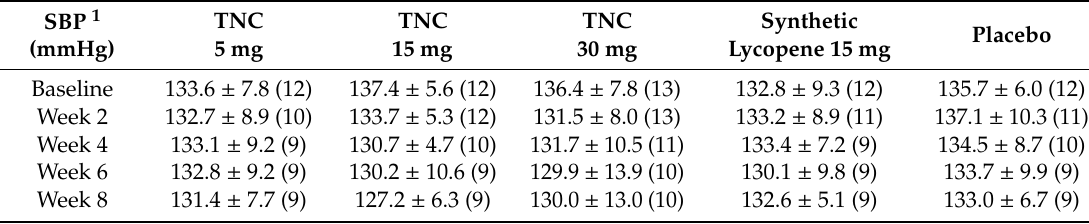
Table 2. SBP during eight weeks of treatment.